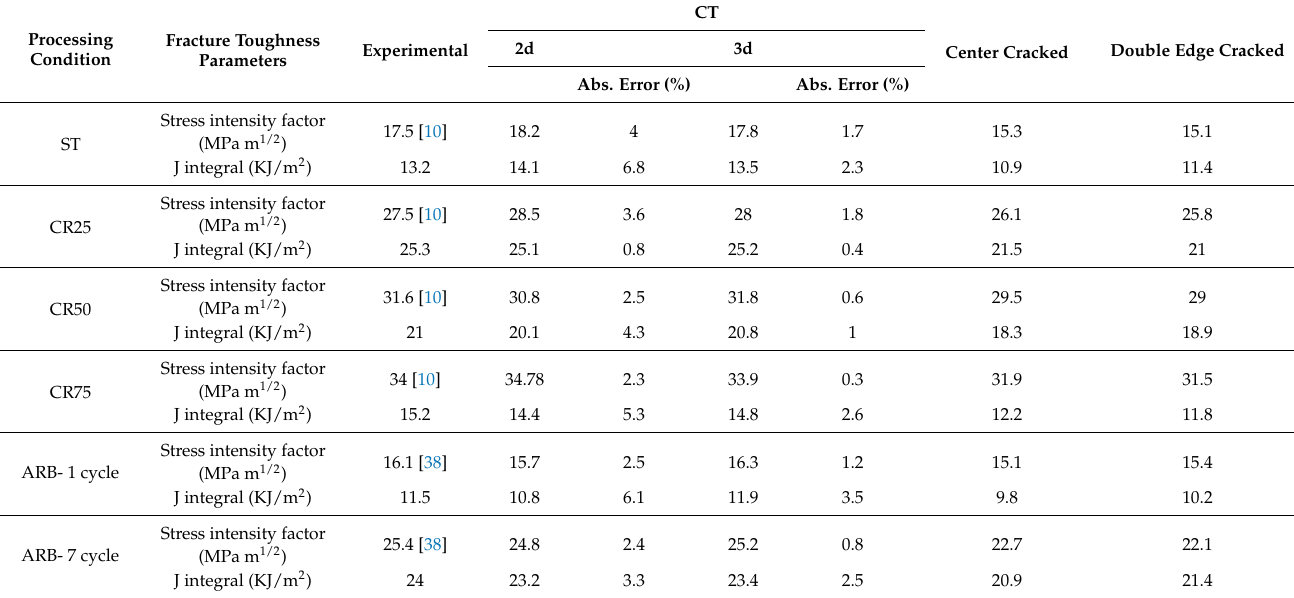
Processing Condition